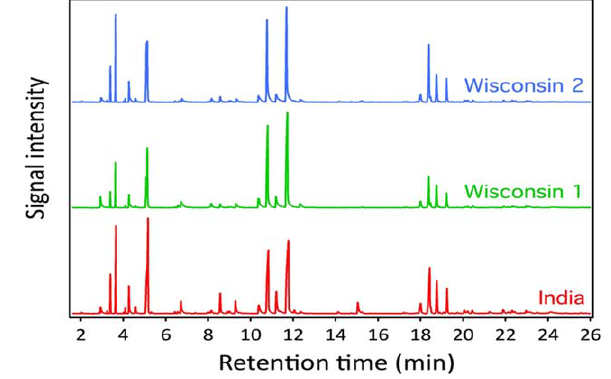
Figure 3. Terpenes are the major components of SDGE identified by GC-MS analysis. Three separate preparations of SDGE, two from the US (termed Wisconsin 1 and 2) and one from India were separated on a non-polar gas chromatography column. The com- pounds separating on this column were identified by mass spectrom- etry. Compounds identified through this analysis along with their relative abundances are shown in Table 1.